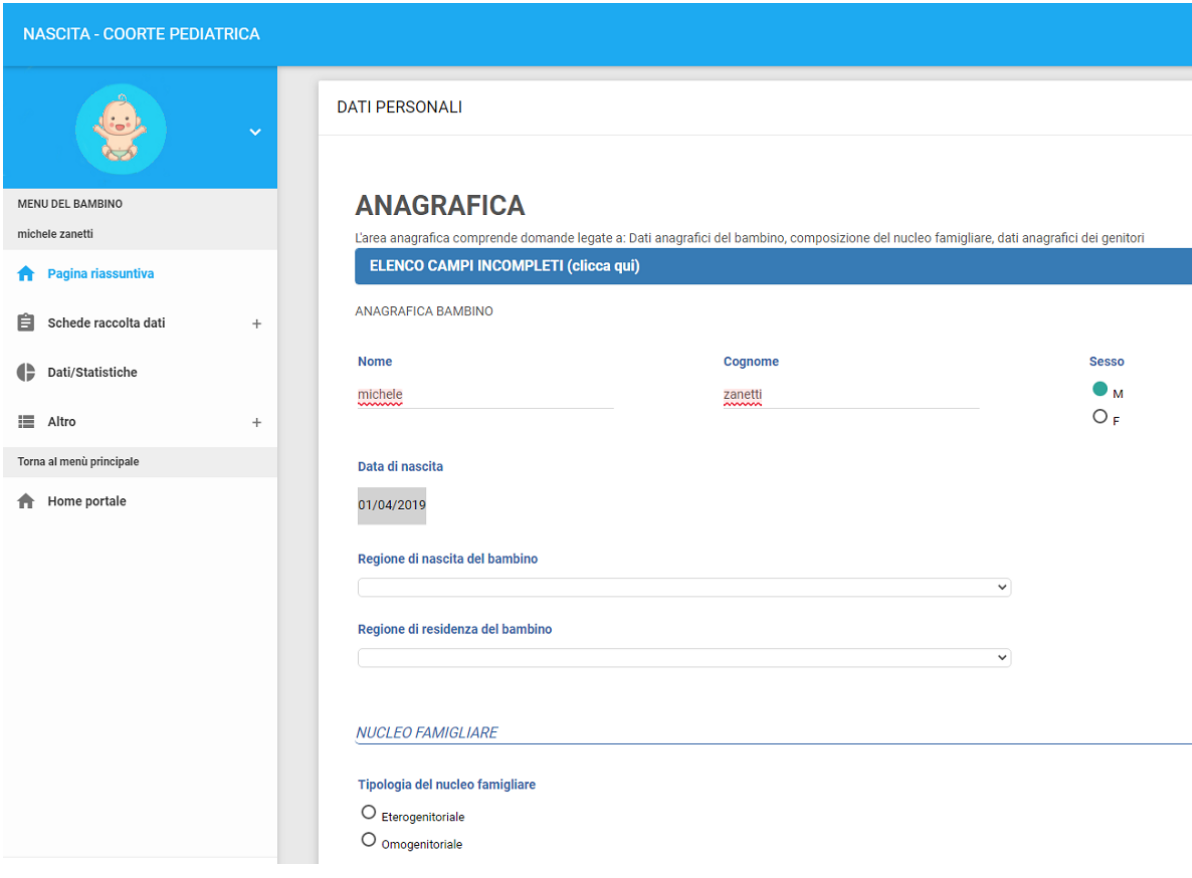
Figure 4. eCRF screenshots: input for second